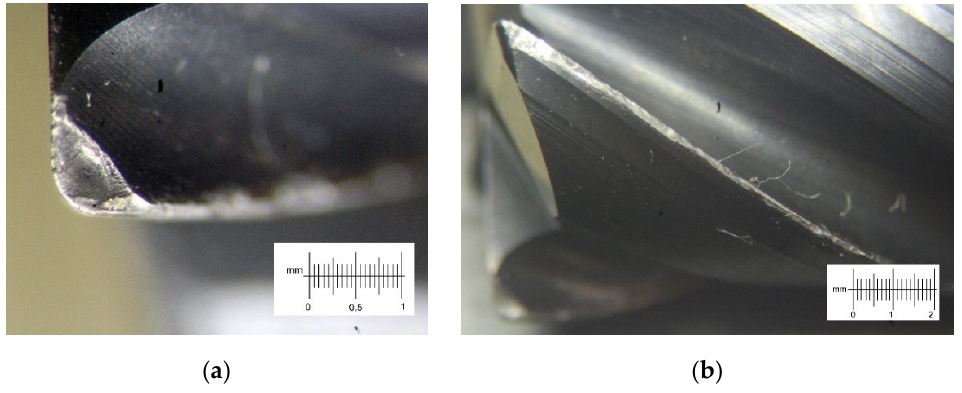
Figure 14. Photo of the wear of cutter No. 3 on the rake ( a ) and flank ( b ) surface.